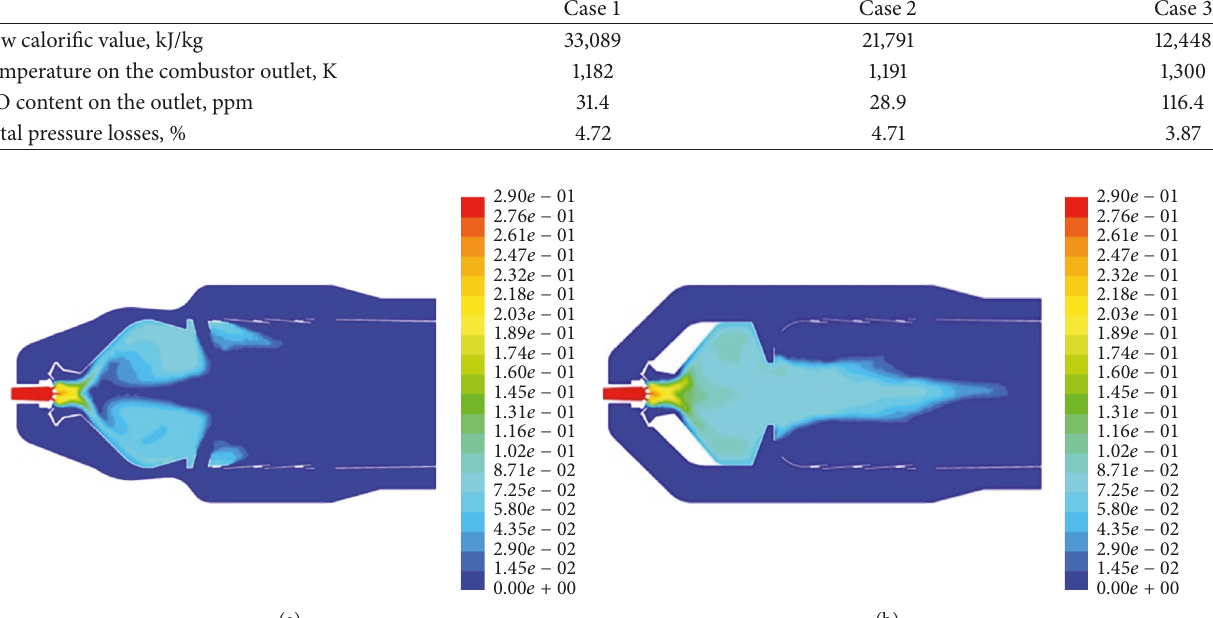
Figure 16: Distribution of CO mass fractions in the longitudinal sections of the combustor: (a) modified design 1; (b) modified design 2.